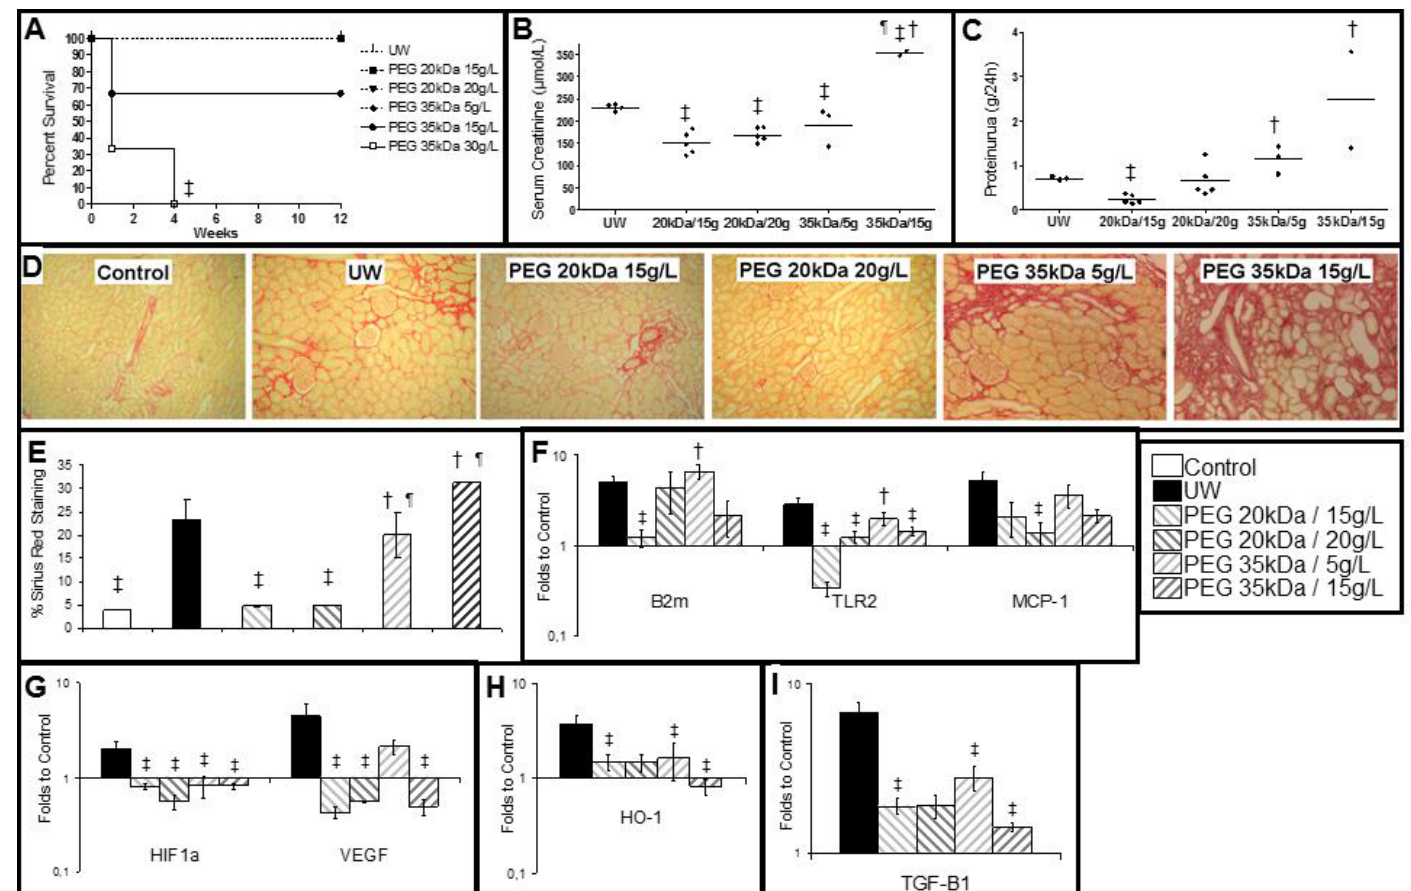
Figure 5. Long Term Outcome. ( A ) Kaplan-Meier curve of animal survival over a period of 3 months; ( B ) Serum creatinine ( µ mol/L); ( C ) Proteinuria (g/24 h); ( D ) Representative images of Sirius Red staining on tissue sections from the different groups (Magnification: 100 × ); ( E ): graphical representation of the amount of fibrosis as % of Red Sirius Staining; ( F – I ) RTqPCR on kidneys at three months. Results are expressed as folds to level of expression in Controls. Shown are mean + SEM. Statistics: ‡ p < 0.05 to UW, ¶ p < 0.05 to PEG 20 kDa/20 g/L and † p < 0.05 to PEG 20 kDa/15g/L. n = 3.